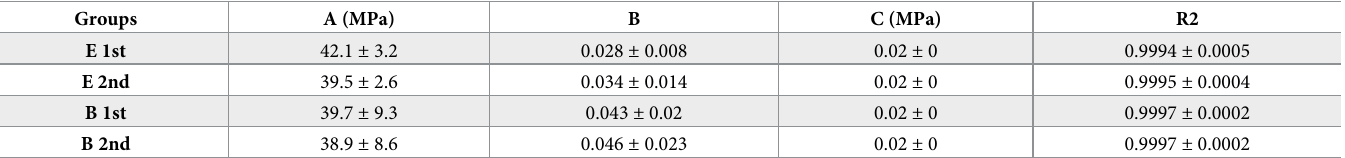
Table 3. Fit parameters for the exponential function (1), which was used to represent stress-strain behavior of samples during the loading step of the last loading- unloading cycle. Groups A (MPa) B C (MPa) R2 E 1st 42.1 ± 3.2 0.028 ± 0.008 0.02 ± 0 39.5 ± 2.6 0.034 ± 0.014 0.02 ± 0 0.9995 ± 0.0004 39.7 ± 9.3 0.043 ± 0.02 0.02 ± 0 0.9997 ± 0.0002 38.9 ±